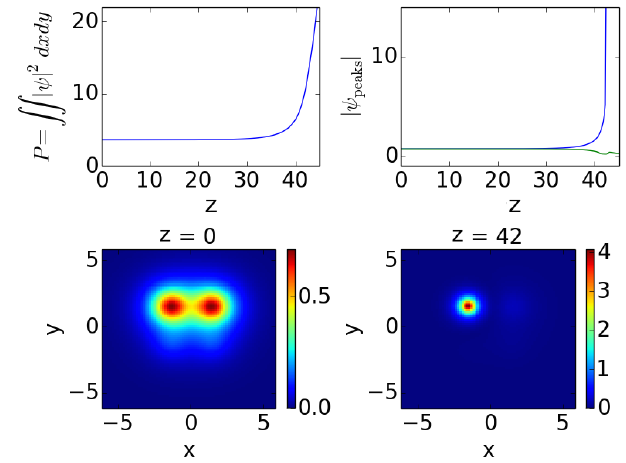
Figure 7. This figure is similar to Figure 5 (with an evolution up to distance z = 42). Here, the plots correspond to the evolution of the branch 3 solution for the value µ ≈ 1.0. In the top right plot, the blue curve corresponds to the left peak of the magnitude of the solution over z and green corresponds to the right peak of the magnitude. Clearly, once again, the gain side of the solution eventually